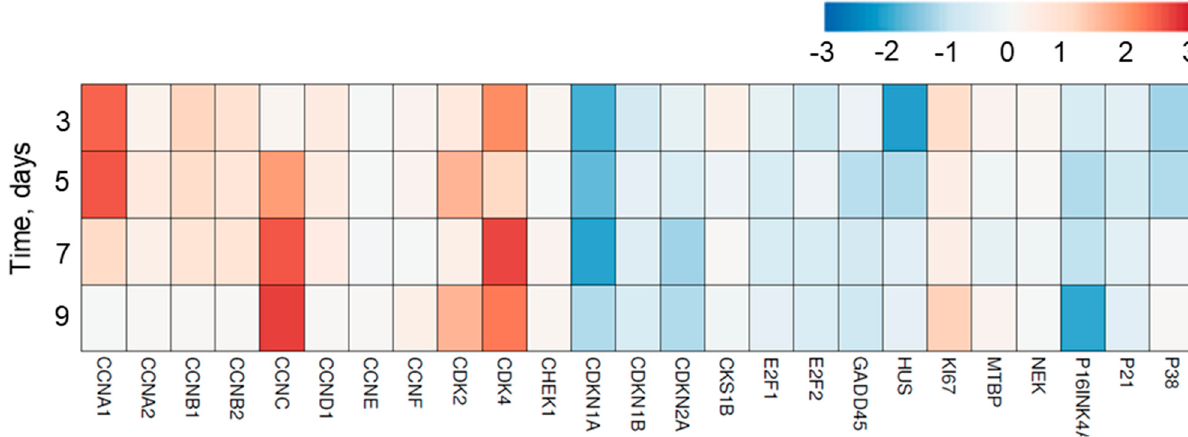
Figure 6. Cell cycle-associated gene expression in cells during ex vivo expansion. Total mRNA was isolated from cells, and mRNA levels were determined by real-time RT-PCR using the Human Cell Cycle PCR Array. The figure depicts a heat map diagram of gene expression in cells within the time of cultivation. Gene expression levels were normalized relative to the mean expression of four reference genes: 18S, GAPDH, HPRT1 and GUSB. The data are color-coded according to the legend and presented as fold change expression relative to initial cells at the 0-day time point. n = 3.